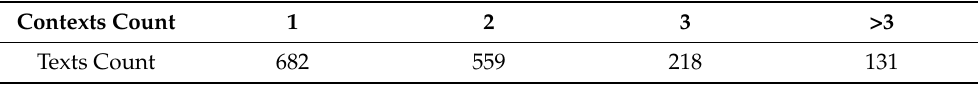
Table 1. The number of texts that contain the corresponding number of